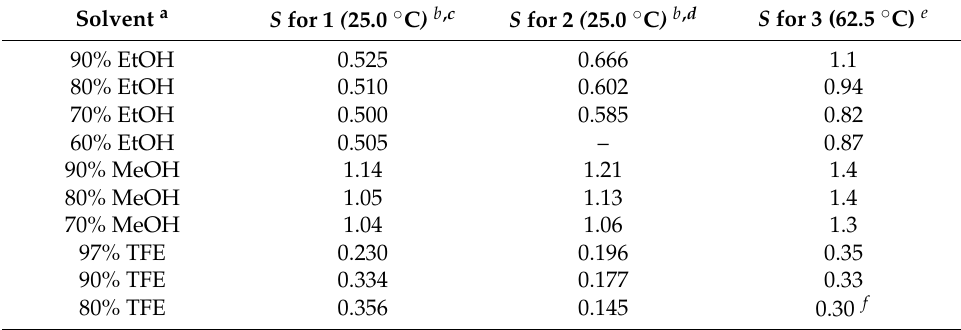
Table 2. Selectivity values (using Equation (9)) for the formation of ester (reaction with alcohol) or amine (reaction with H 2 O) in the solvolyses of N , N -dimethylcarbamoyl chloride ( 1 ), 4-morpholinecarbonyl chloride ( 2 ), and N , N -diphenylcarbamoyl chloride ( 3 ).